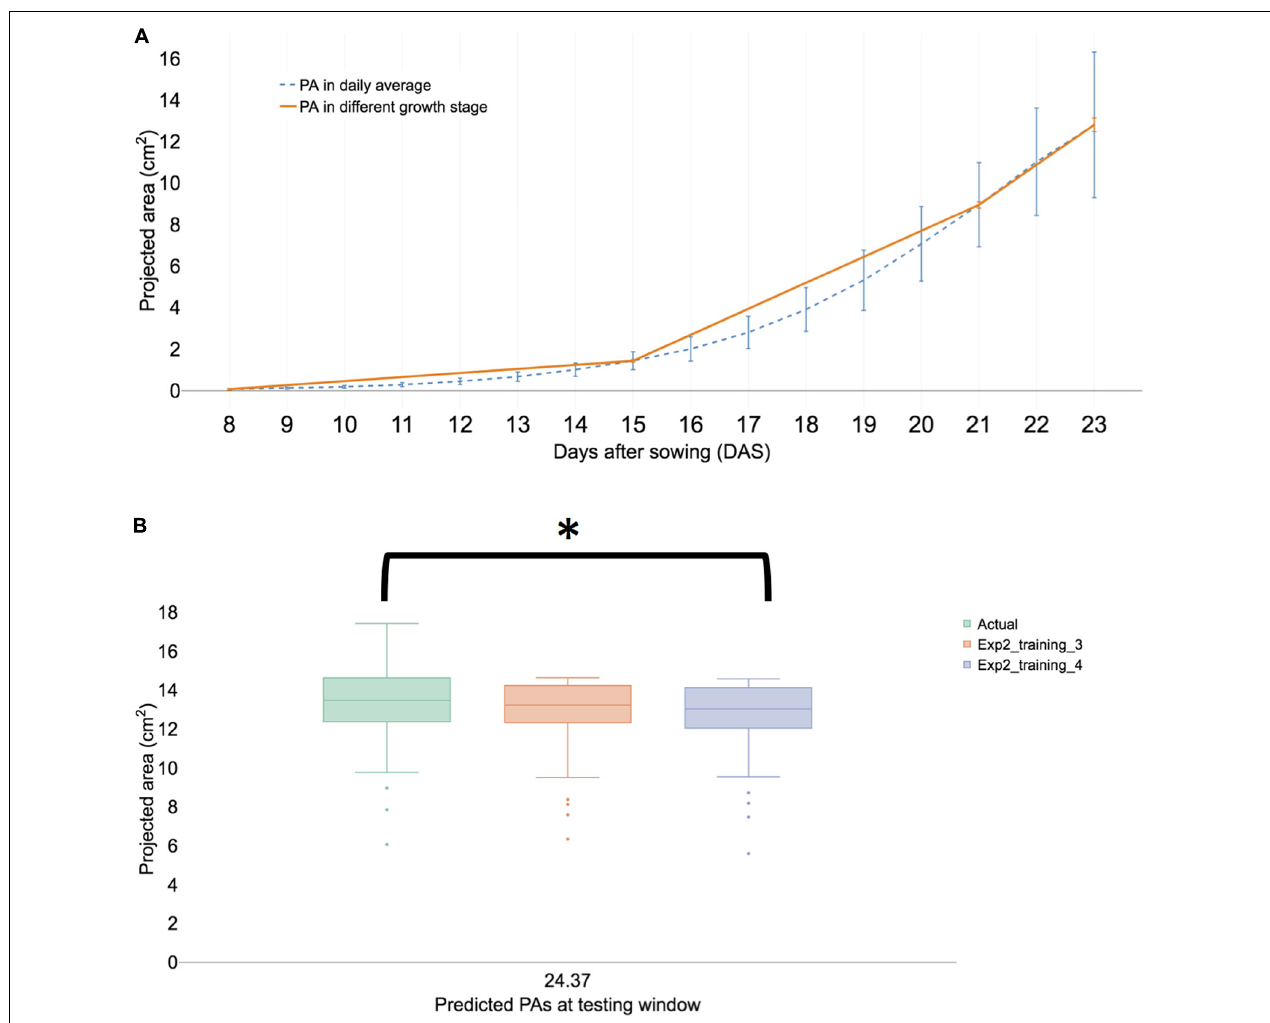
FIGURE 5 | Summary of a biological replication study at experiment II. (A) The visualized growth pattern of all samples of biological replication experiment including three growth stages. (B) Predicted PAs with training sets 3 and 4 with testing window at 23 DAS. The result is shown in a boxplot of actual and predicted PAs from each testing model. We then compared with post hoc statistical test (Tukey’s HSD) and the significant result is shown with an